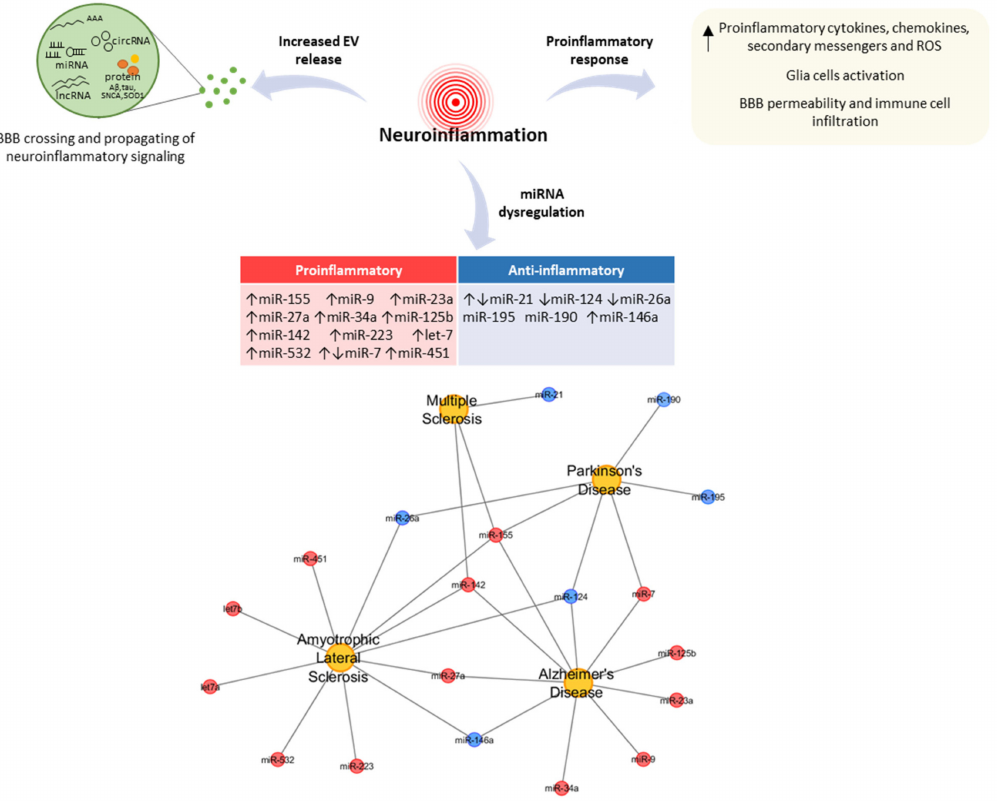
Figure 1. Schematic representation of the neuroinflammatory processes in neurodegenerative diseases (NDDs). CNS-resident cells su ff er an activation process that leads to an increased release of extracellular vesicles (EVs) and the secretion of proinflammatory mediators, inducing the mutual activation of glial cells, BBB permeability, and the infiltration of peripheral immune cells. In the lower part, a schematic list of inflammatory miRNAs involved in NDDs is shown; the relative network was visualized using Cytoscape